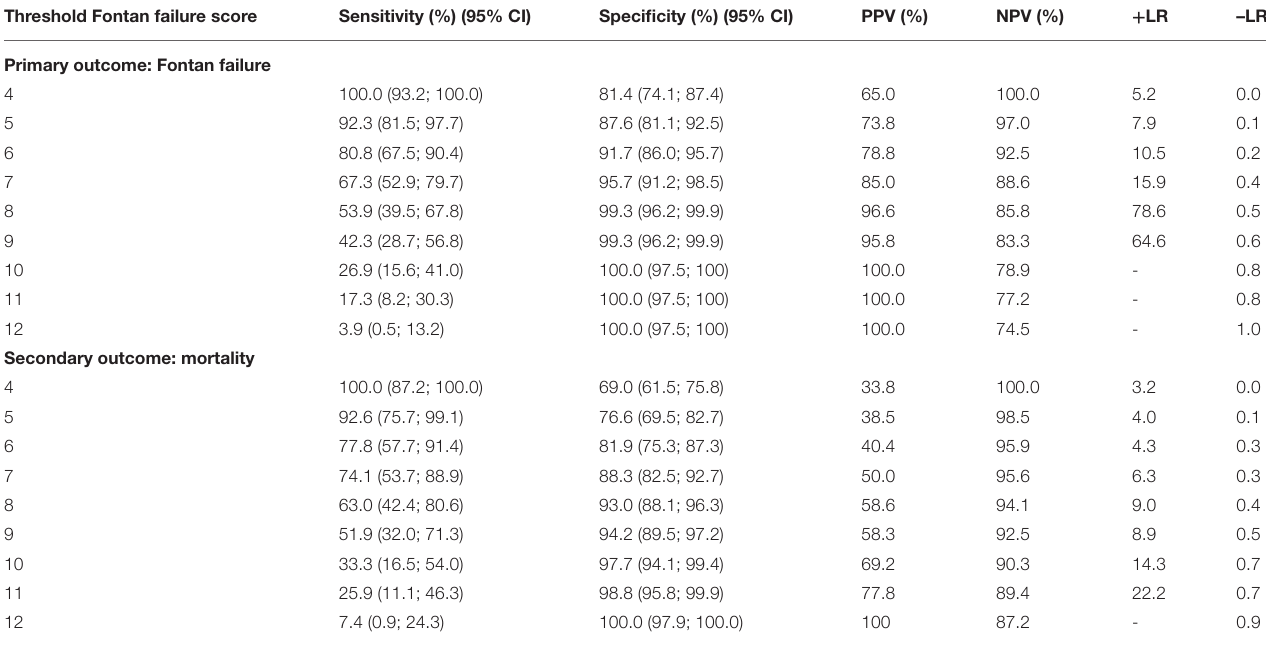
TABLE 3 | Fontan Failure Score accuracy according to